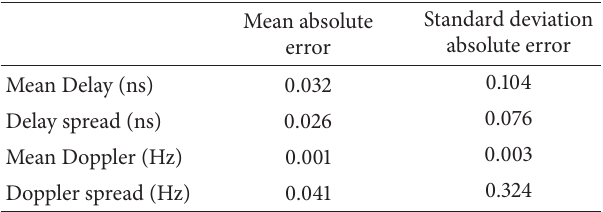
Table 1: Mean and standard deviation of the absolute errors of the considered characteristic